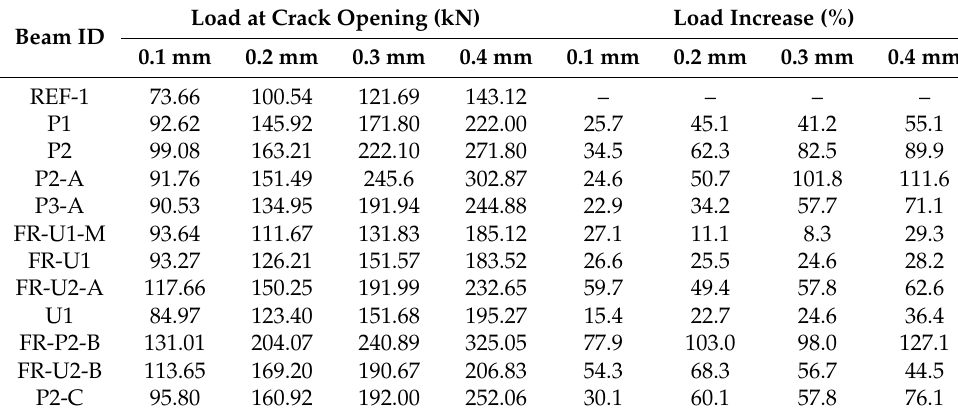
Table 3. Cracking loads and relative